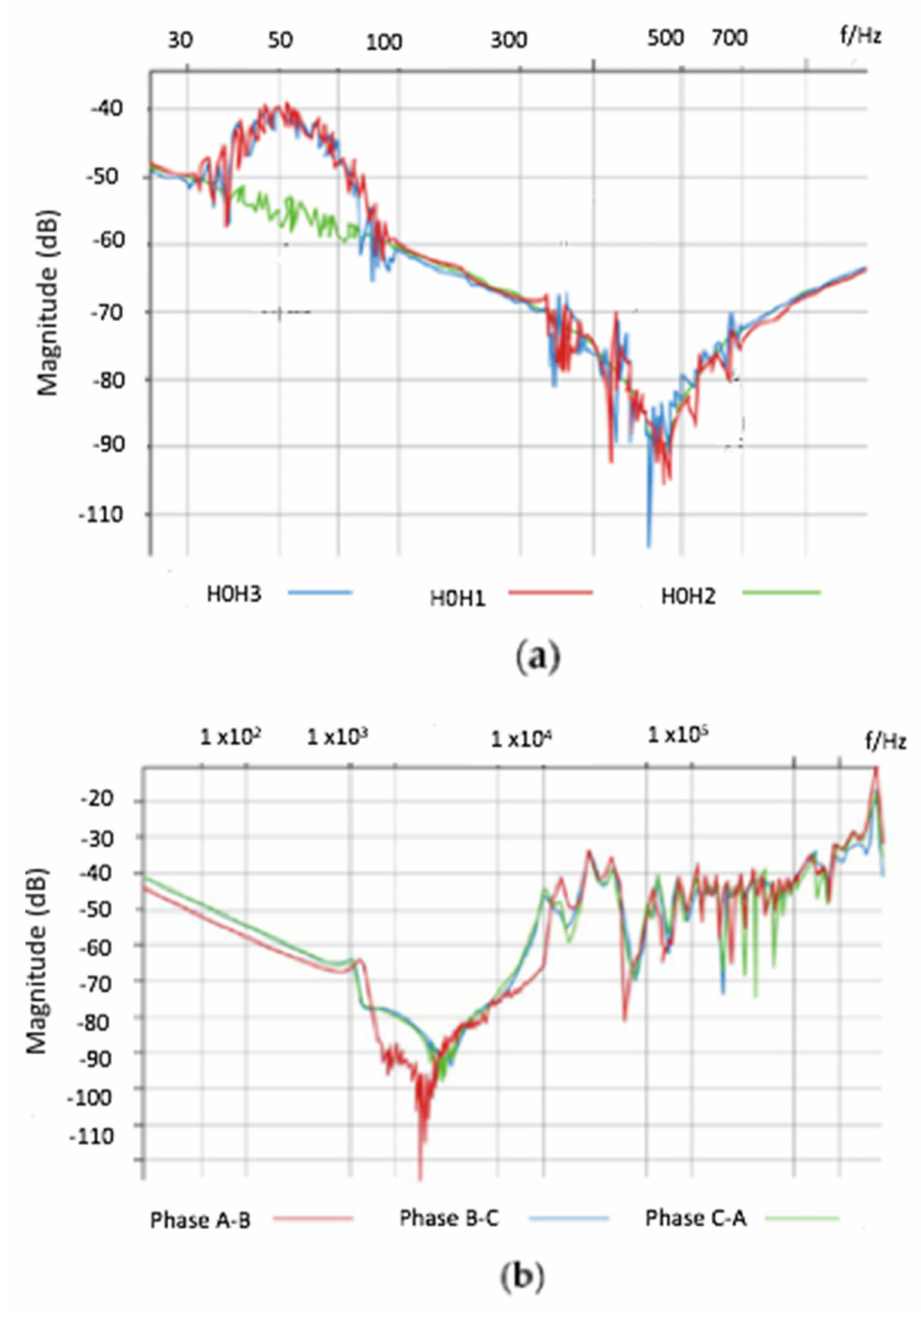
Figure 3. ( a ) Typical narrow-band interference. ( b ) Typical broadband interference. Table 1. Proposed numerical frequency response